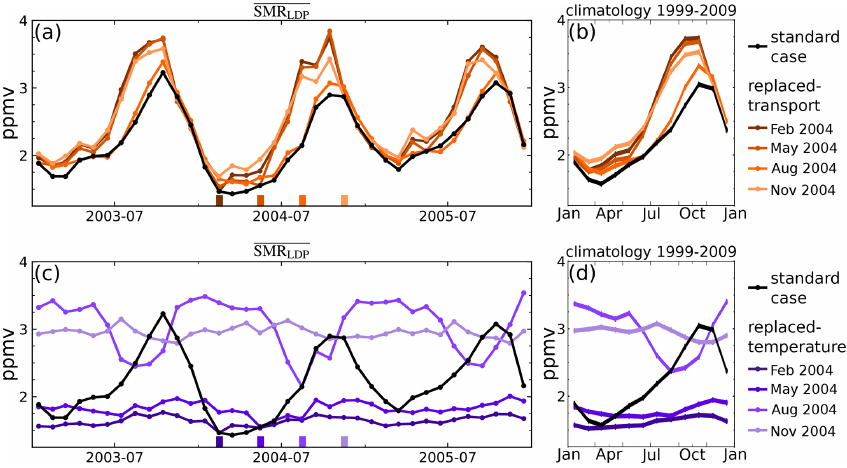
Figure 5. (a) Time series of SMR LDP between 2003–2005 for the ERA-Interim standard case (black line) and replaced-transport time series with wind field initialised to a fixed month of 2004 (orange lines); (b) equivalent average annual cycle over 1999–2009. Panels (c) and (d) as for panels (a) and (b) but for replaced-temperature time series with temperature field initialised to a fixed month of 2004 (purple lines). Line shade corresponds to particular months marked with ticks; see also